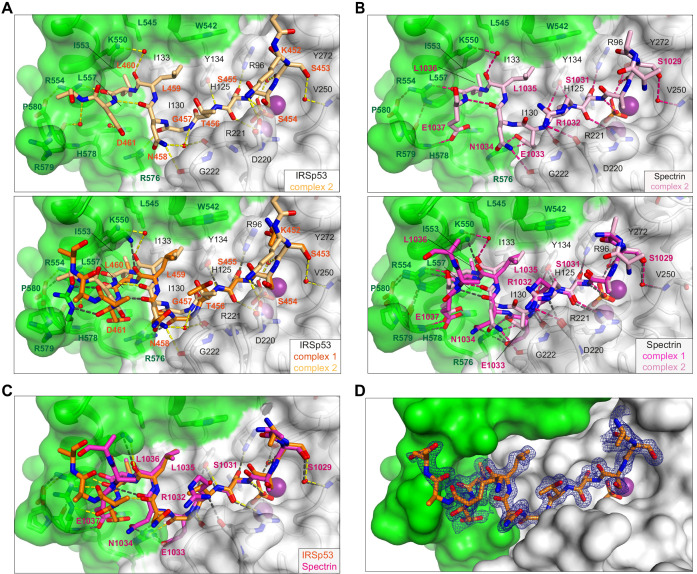
Substrate interactions in the Phactr1/PP1 complex.(A, B) Structure of the second copy of the Phactr1/PP1-substrate complexes in each asymmetric unit. Each structure is shown alone (top), and superimposed on the first copy (bottom; see Figure 4). (A) In IRSp53 complex 2, the electrostatic interactions between substrate residues +4, +5 and +6 and Phactr1 basic residues are water-bridged rather than direct. (B) In spectrin complex 2, the E1033/N1034spectrin peptide bond is inverted, losing the mainchain carbonyl and N1034spectrin sidechain interactions with Phactr1 R576, and the hydrogen bonding interaction between the L1035spectrin(+4) carbonyl and Phactr1 K550 is water-bridged rather than direct. (C) Superposition of the first copy of each complex (shown separately in Figure 4A and B). (D) Omit map contoured at 3σ of the first copy of the IRSp53 complex.